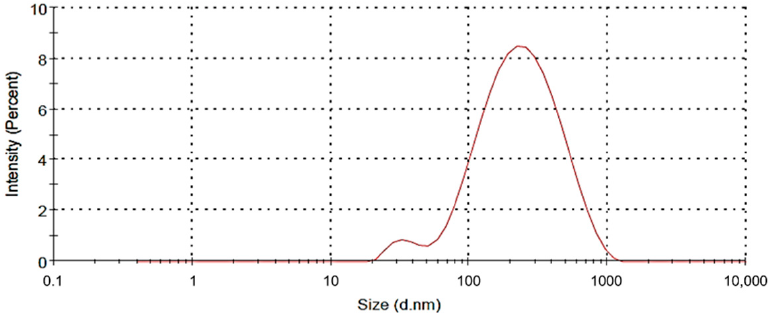
Figure 2. Particle size distribution of HCQ-NLC.